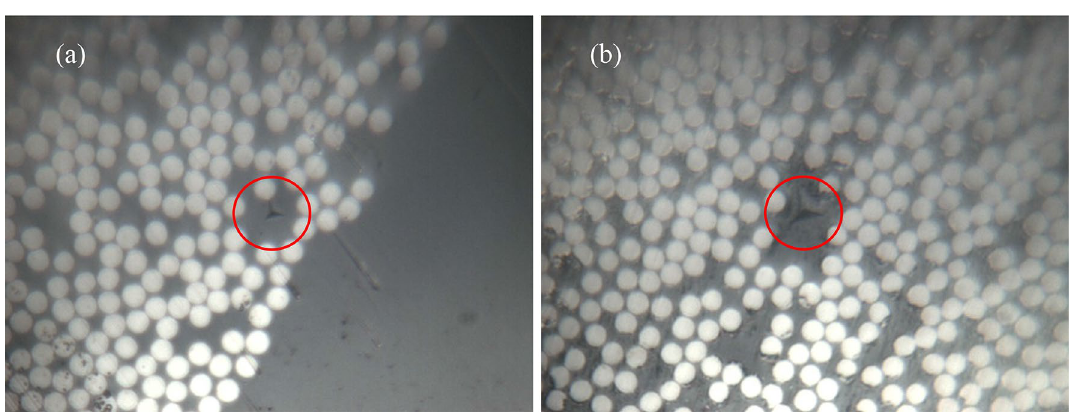
Figure 6. Optical images (40 × of magnification) of ( a ) reference and ( b ) recycled composite surfaces showing the indent point location (red